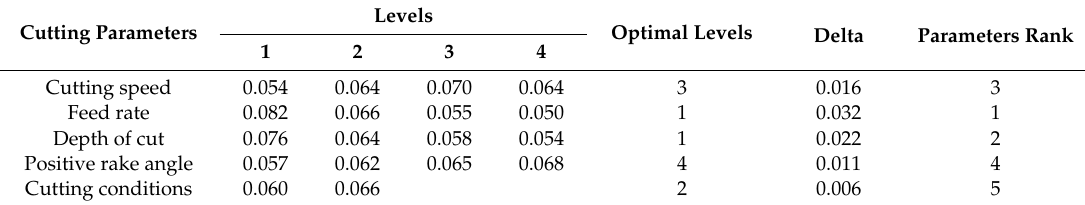
Table 9. Optimal levels based on average normalized assessment values and the importance of parameters.